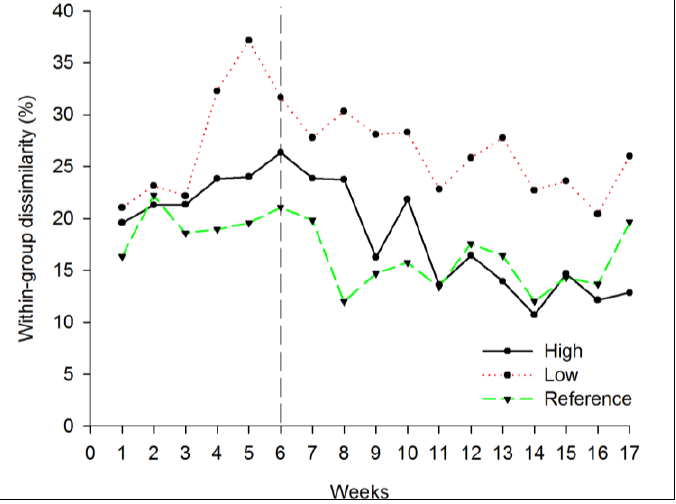
Figure 2. Within-group dissimilarity in rock pools disturbed by nutrient enrichment. The black vertical line represents the beginning of the disturbances. High = nutrients added every diurnal low tide; Low = nutrients added six times during the period, Reference = no nutrient added. Note that high within-group dissimilarity is associated with high beta diversity.